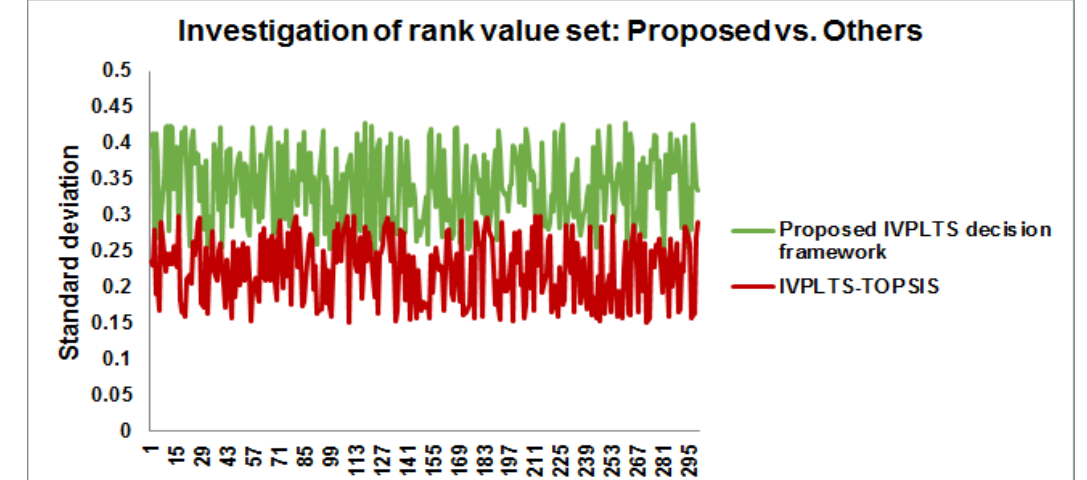
Figure 3. Analysis of the rank value set using standard deviation: Proposed vs. others. Table 8. Investigation of adequacy test: Proposed vs.